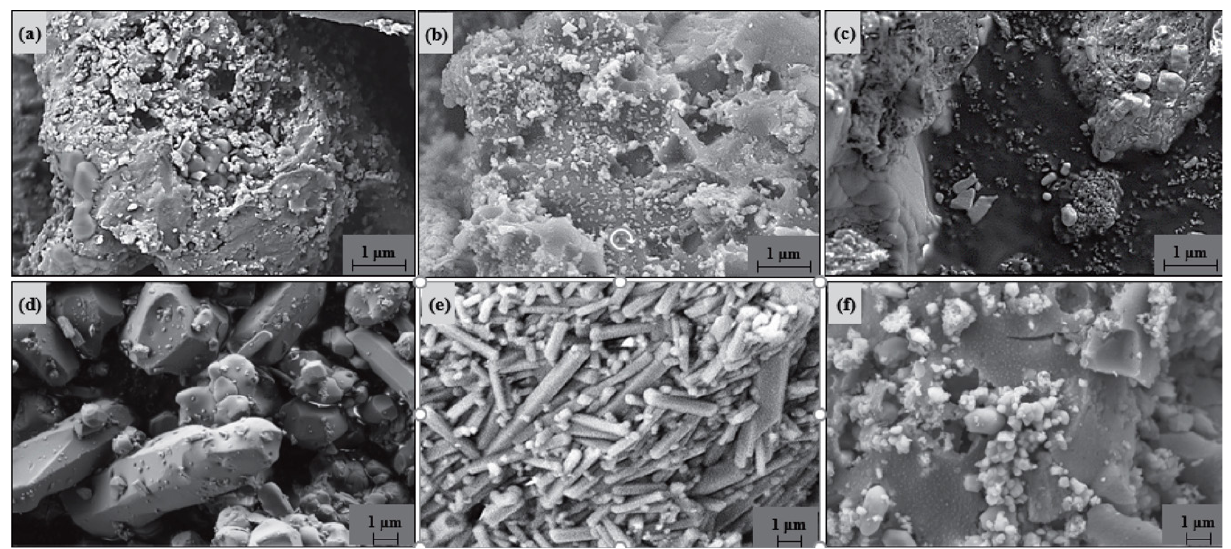
Figure 8. SEM images of T1ABC (upper row) and T2ABC (bottom row) samples at heating rates 5 °C min − 1 (a and d), 20 °C min − 1 (b and e) and 100 °C min − 1 (c and f).